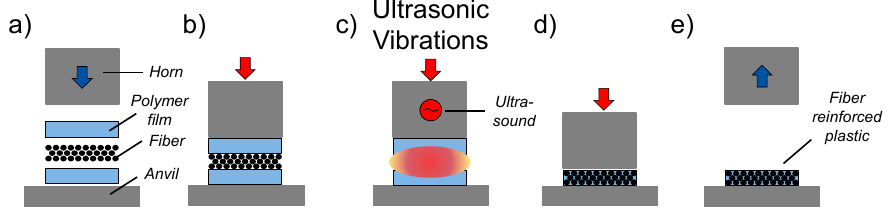
Figure 1. Schematic illustration of the ultrasonic fabrication of carbon fiber reinforced polymer composite (CFRP): ( a ) Carbon fibers placed between polymer layers on top of the anvil and under the horn of an ultrasonic welding machine. Down stroke of the horn; ( b ) Buildup of a mechanical force by